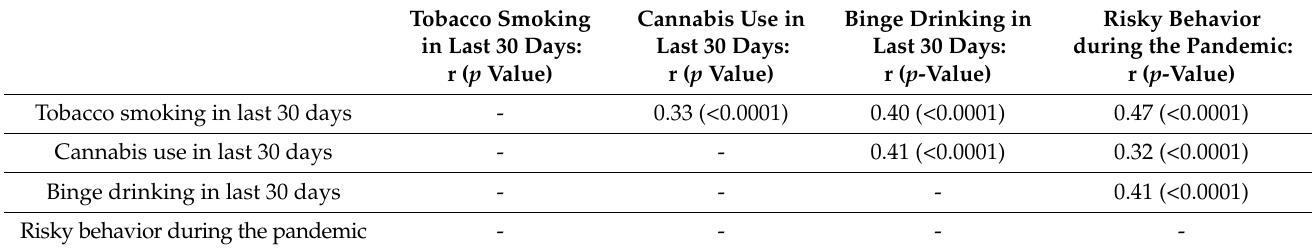
Table 3. Associations between risk behaviors (Spearman rank correlation coefficients; n =